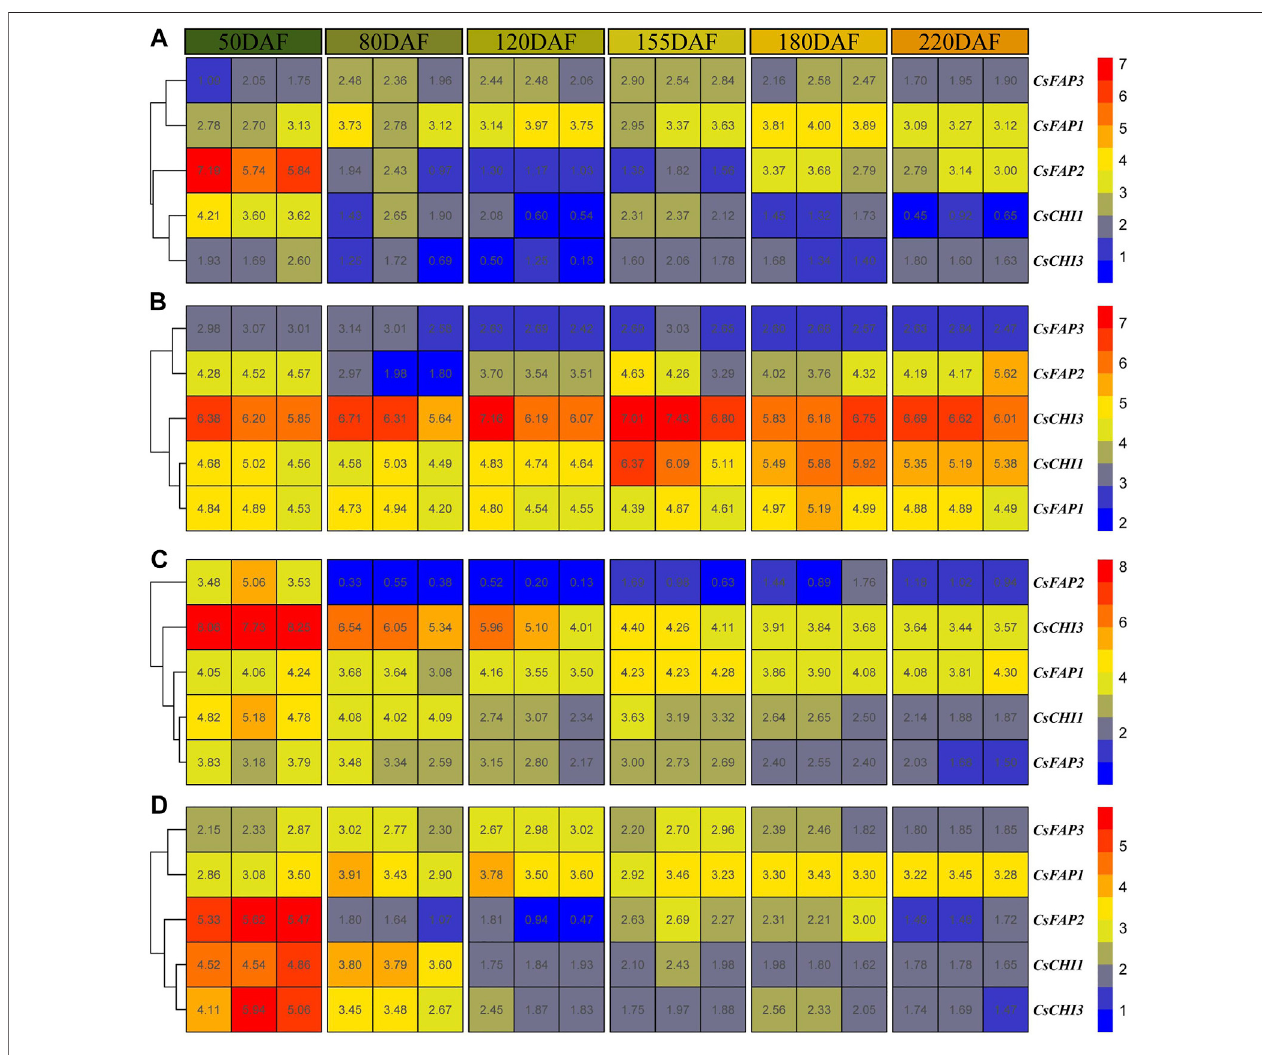
FIGURE4| Expressionpatternof CHI genesduringthefruitdevelopment. (A – D) showstheexpressionpatternsof CHI genesinthealbedo,epicarp,juicesac,and segment membrane, respectively. 50, 80, 120, 155, 180, and 220 DAF represent 50, 80, 120, 155, 180, and 200 DAF, respectively.